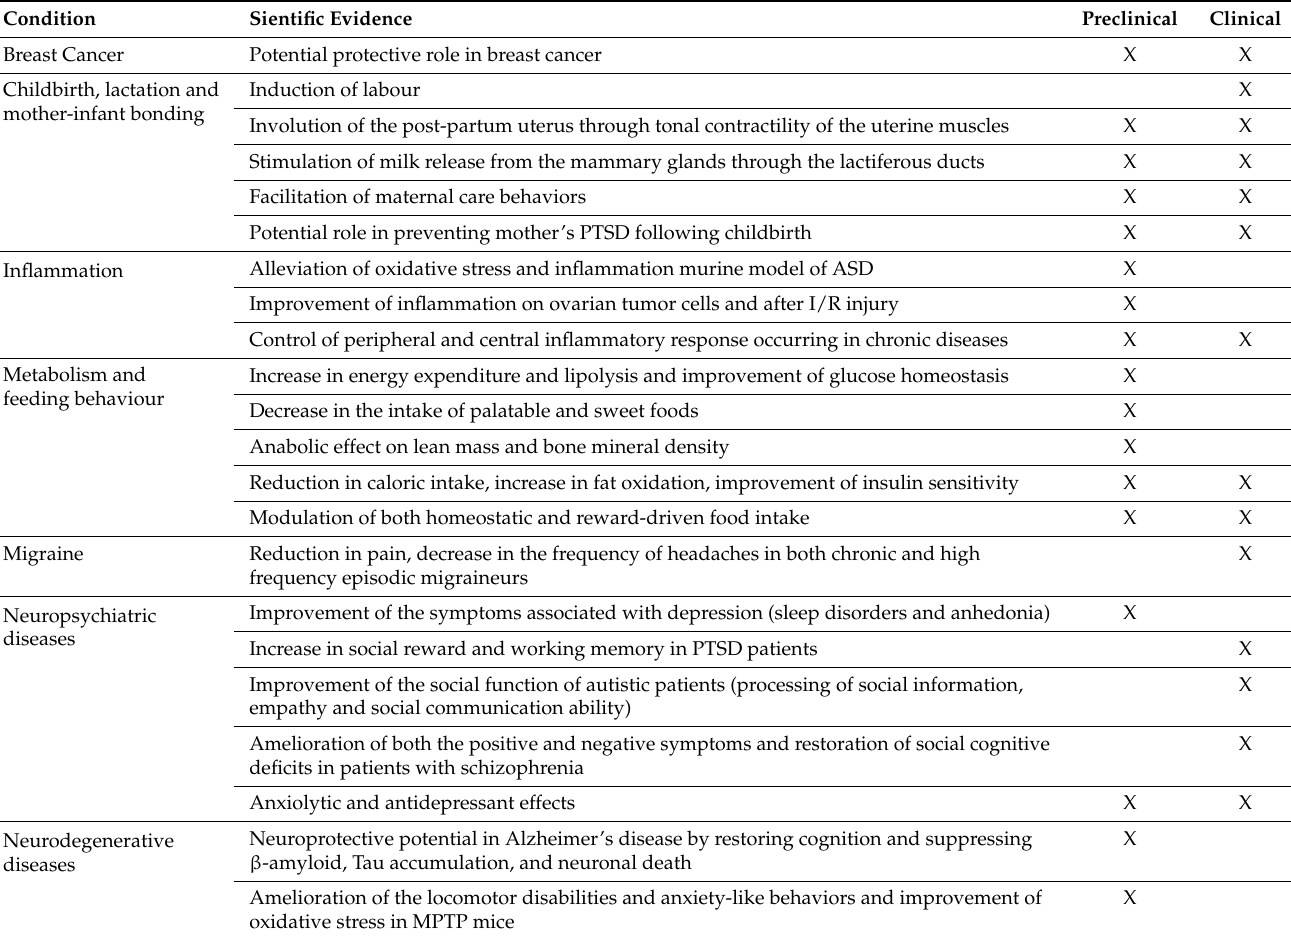
Figure 1. Therapeutic Potential of Targeting the Oxytocinergic System. Table 1. Preclinical and clinical evidence of oxytocin potentiality in several physiological and pathological conditions .